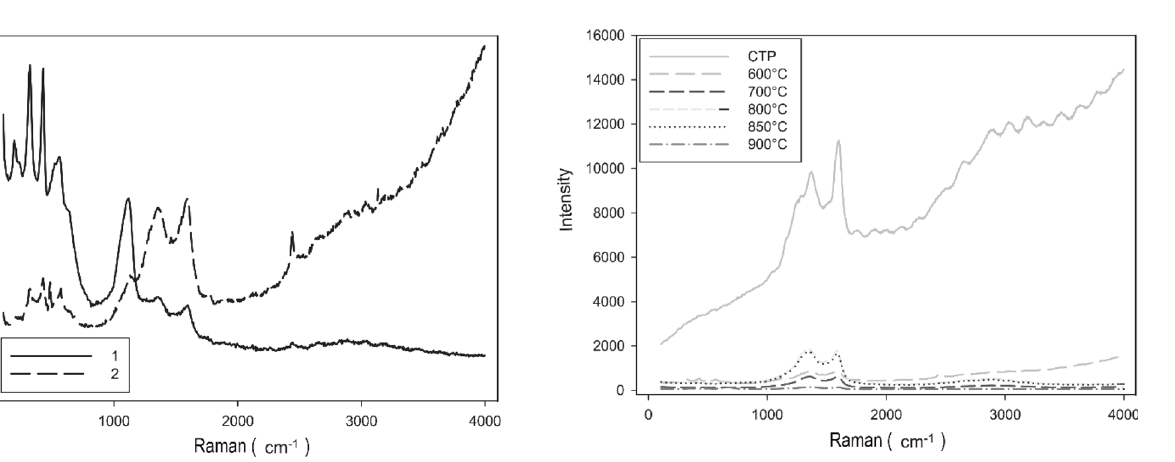
Fig. 5 RS results for a sample of CTP and solids obtained at different working temperatures